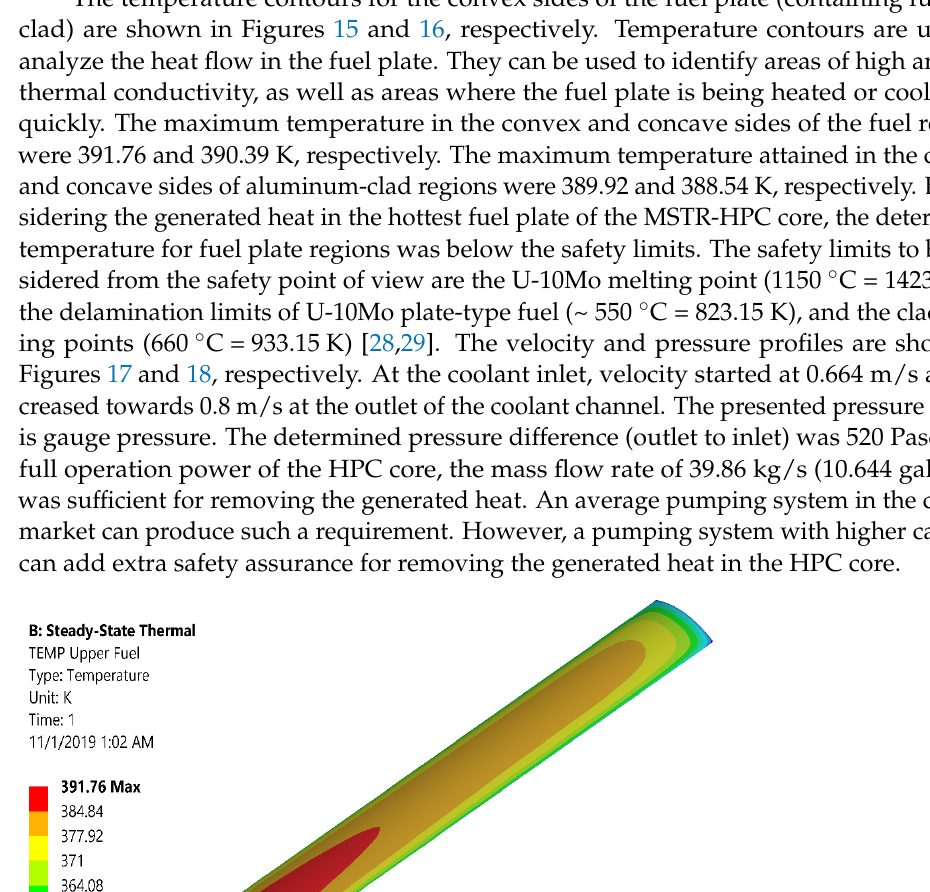
Figure 16. Temperature contours for the convex side of Clad. Figure 17. Velocity profile of coolant channel.